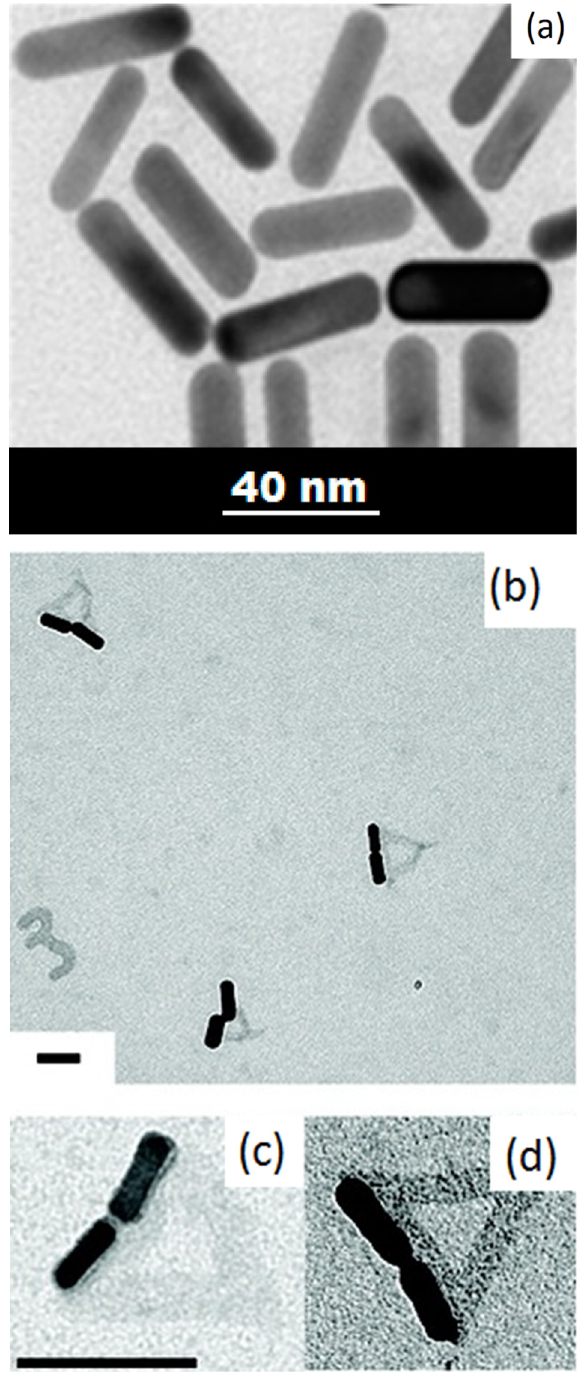
Figure 4. TEM image of self-assembled AuNRs: ( a ) Self assembled AuNRs with a dimension of 10–40 nm. Adapted from [153]; ( b ) Self assembled AuNRs with a dimension of 5–50 nm, functionalized by DNA. Adapted with permission from [157]. Copyright (2011) American Chemical Society; ( c ) Self assembled AuNRs with a dimension of 5–50 nm, functionalized by DNA. Adapted with permission from [157]. Copyright (2011) American Chemical Society. The scale bars in the ( b , c ) images are 100 nm.